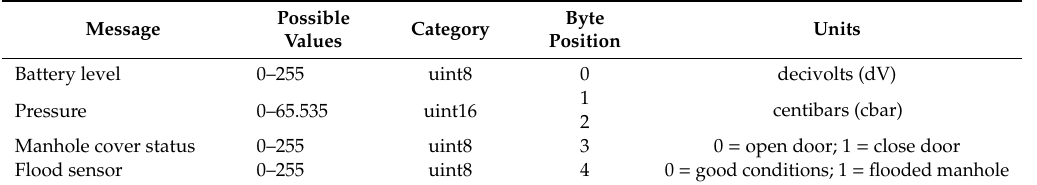
Table 2. The variables and their format transmitted in each